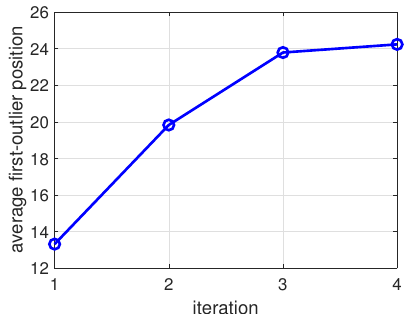
Figure 7. The average FOP after 4 iterations for all the correspondences on a pair of